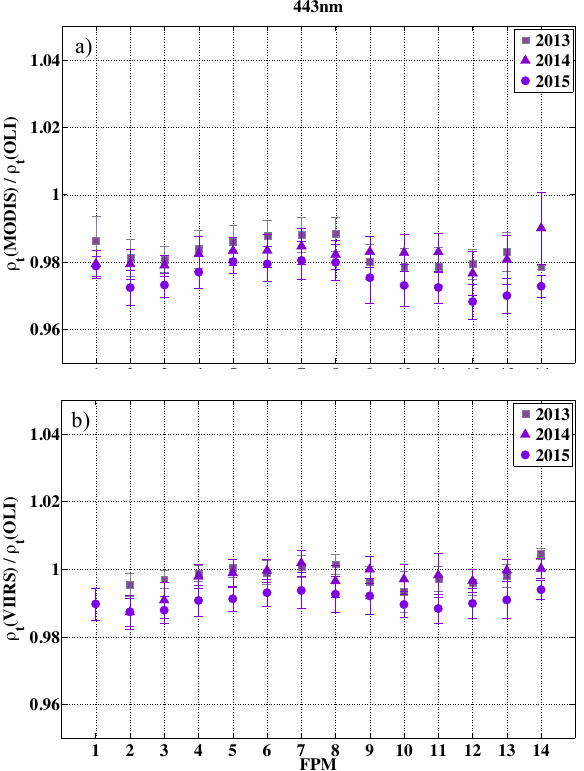
Figure 3. The ratio of OLI and MODIS (a) and VIIRS (b) TOA reflectances across the OLI focal plane shown as a function of the focal plane modules (FPM). The error bars indicate the intercomparison uncertainty.